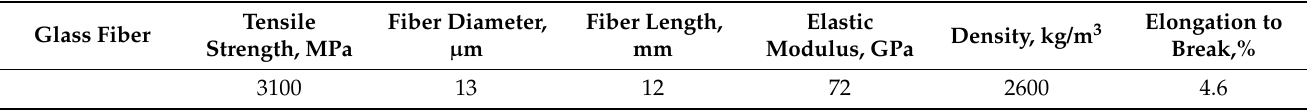
Table 5. Physical and mechanical properties of